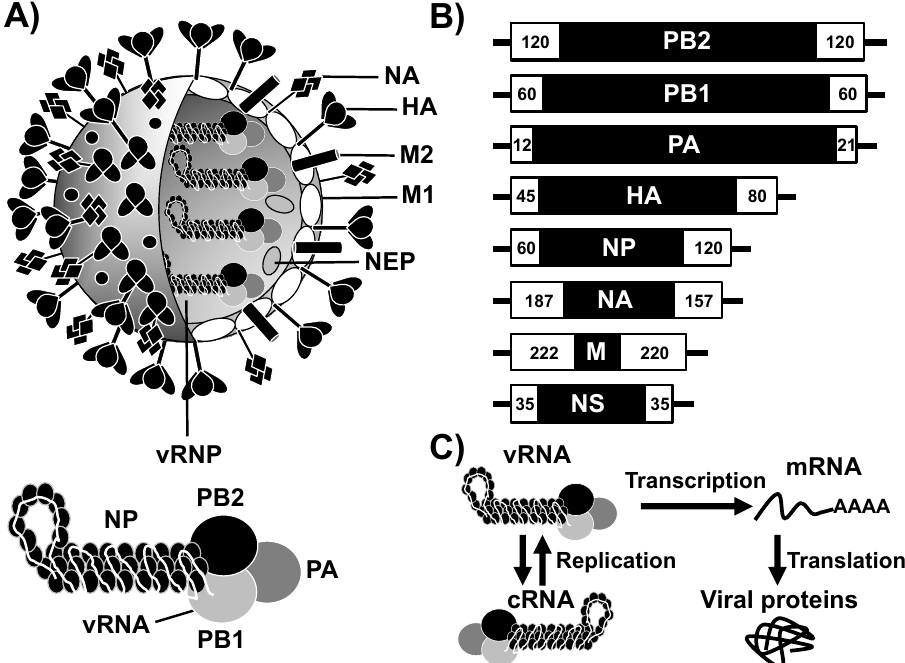
Figure 1. Influenza A virion structure, genome organization, and viral replication and transcription. ( A ) Virion structure: IAV are surrounded by a lipid bilayer containing the two viral glycoproteins hemagglutinin (HA) and neuraminidase (NA). Also, in the virion membrane is the ion channel matrix 2 (M2) protein. Under the viral lipid bilayer is a protein layer composed of the matrix 1 (M1) protein and the nuclear export protein (NEP). Inside the virion are the eight viral (v)RNA segments that are encapsidated by the viral nucleoprotein (NP) as viral ribonucleoprotein (vRNP) complexes. Associated with each vRNP is the viral RNA-dependent RNA polymerase (RdRp) complex made of the three polymerase subunits PB2, PB1, and PA that, together with the viral NP are the minimal components required for viral replication and transcription. Viral proteins in the virion particle (top) and in the vRNP (bottom) are indicated. The viral proteins showed in the illustration of the viral particle do not maintain the stoichiometric that is found in a mature virion. ( B ) Genome organization: IAV contain eight single-stranded, negative-sense, viral RNA segments (PB2, PB1, PA, HA, NP, NA, M, and NS). Each viral segment contains non-coding regions (NCR) at the 3′ and 5′ ends (black lines). Also, at the 3′ and 5′ end of the viral RNAs are the packaging signals, responsible for the efficient encapsidation into nascent virions (white boxes). Numbers represent the nucleotide length of the 3′ or 5′ packaging signals in each of the viral RNA segments. ( C ) Viral genome replication, transcription and translation: IAV NP and the viral polymerase complex PB2, PB1, and PA associated with the viral RNA form the vRNP complexes that are responsible for viral replication and transcription. vRNP complexes initiate transcription from the viral promoters located within the NCR at the 3′ termini of each of the vRNAs. Transcription results in the synthesis of IAV mRNA that are translated to proteins. IAV polymerase complex is also involved in the replication of the vRNA into a complementary (c)RNA that serve as template for the amplification of vRNAs. Newly synthesized vRNPs, together with the structural viral proteins result in the formation of new IAV.